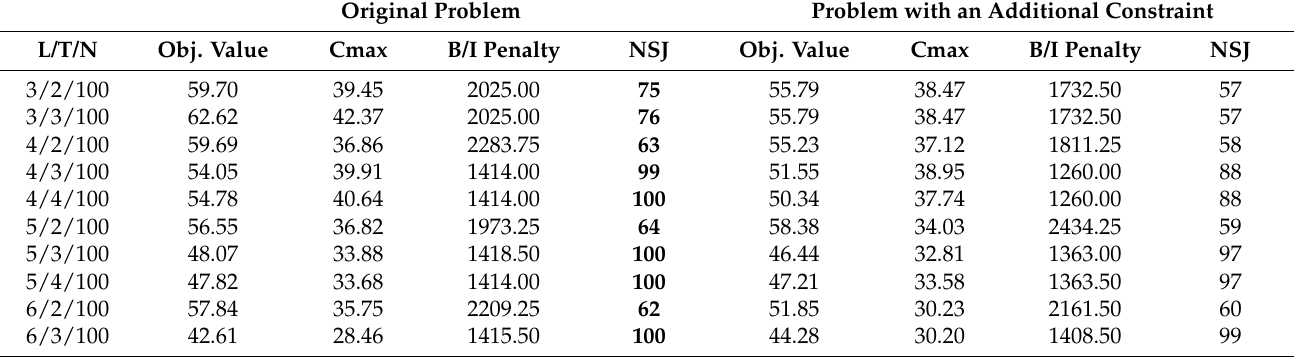
Table 5. Impacts of additional constraints.